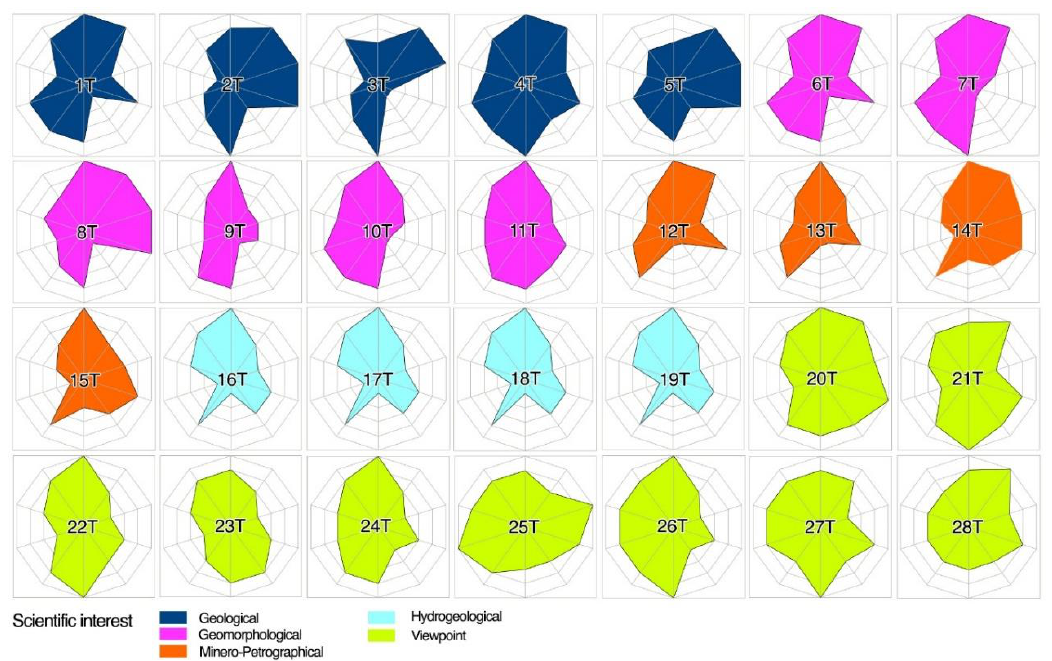
Figure 6. Multivariate representation of the results of terrestrial geosite assessment. Along the axes, the quantitative results of the assessment of the scientific, additional, and potential for use values and their sub-criteria are shown for each terrestrial geosite (for axis legend, see Figure 7). The colors represent different scientific interests, as specified in the figure legend.